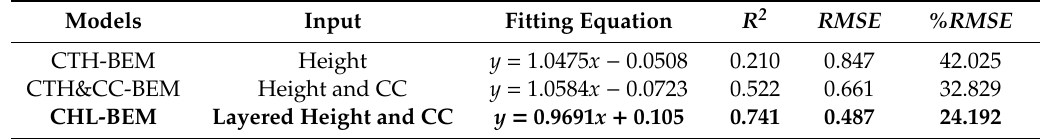
Table 1. Comparison of three di ff erent GLAS biomass estimated models. In this table, x represents the model-estimated biomass, and y represents the field-estimated